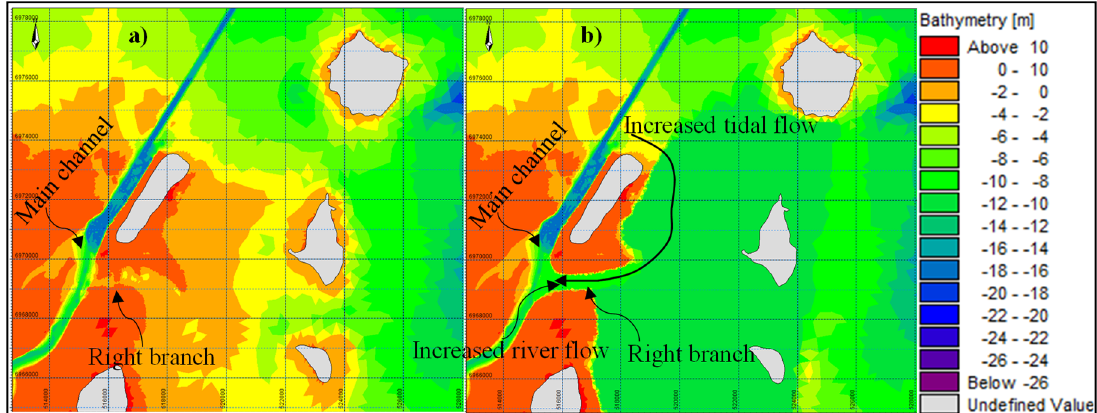
Figure 9. Brisbane River intake: ( a ) normal intake right branch, ( b ) dredged and widened intake branch.